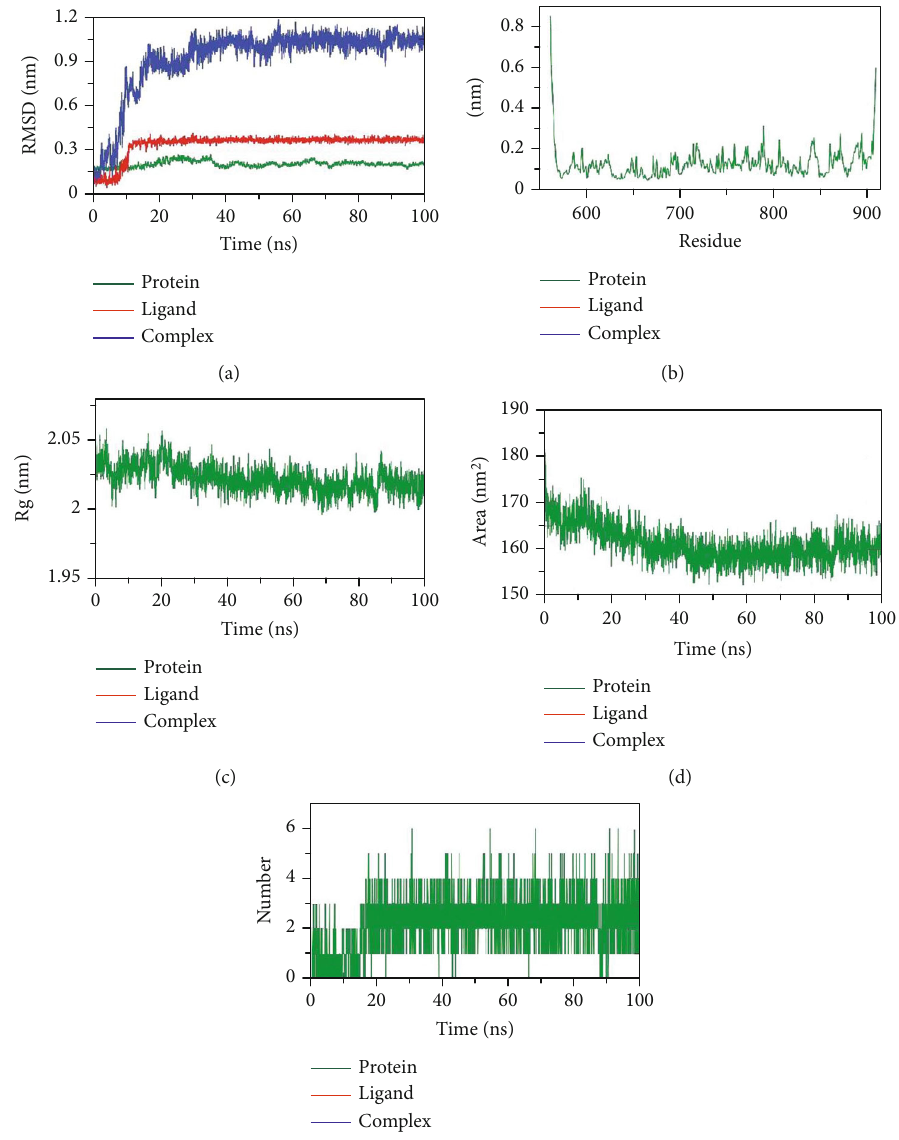
Figure 19: MD simulation trajectory analysis of (a) root mean square deviation (RMSD) of quinovic acid bound with 7T9K at 100-ns time frame, (b) root mean square fl uctuation (RMSF), (c) radius of gyration (Rg), (d) solvent accessible surface area plot of quinovic acid bound with 7T9K at 100-ns time frame, and (e) number of H-Bond plot of quinovic acid bound with 7T9K at 100-ns time